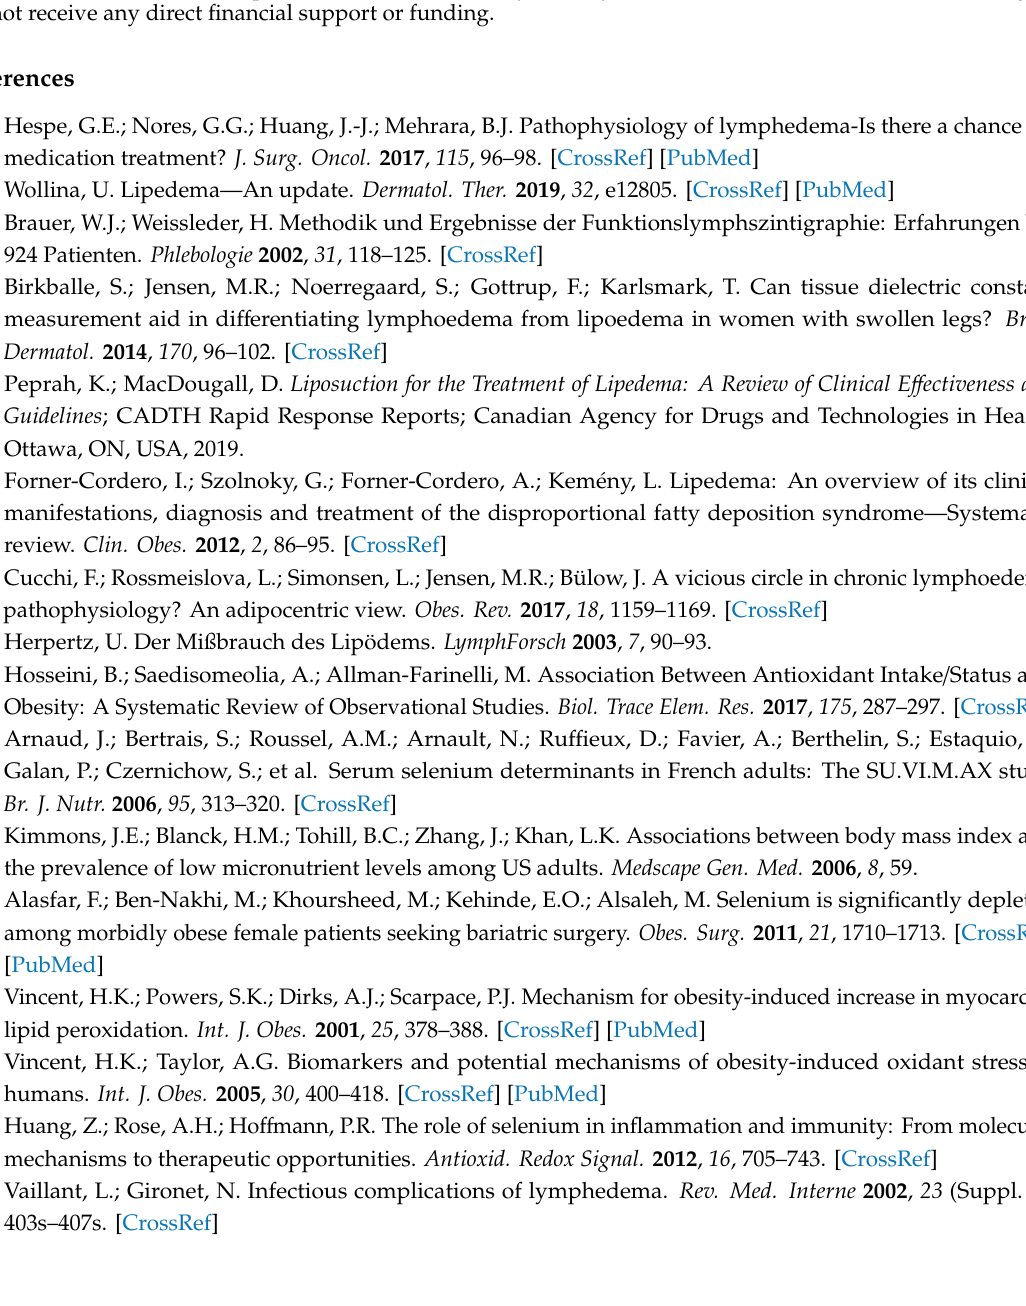
Table S1: Descriptive characteristics of patients stratified for BMI. Table S2: Selenium concentration in obese and morbidly obese patients with lymphedema, lipo-lymphedema, and lipedema. Table S3: Obesity in lymphedema, lipo-lymphedema, and lipedema in two time